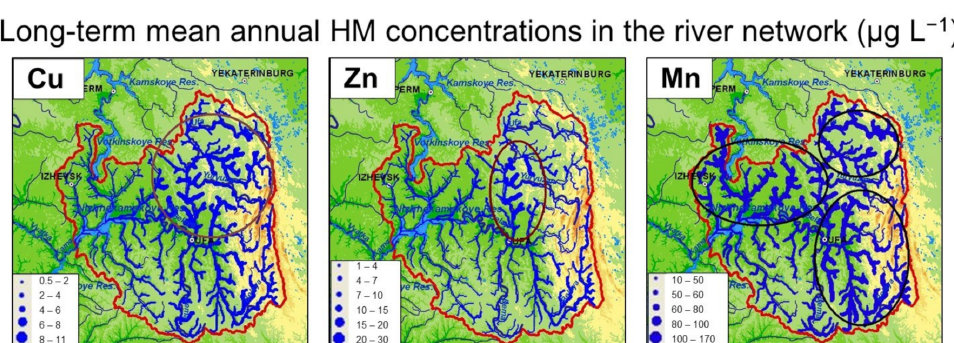
Figure 7. Initial HM contents in the soils, long-term mean annual HM wash-off, and long-term mean annual HM concentrations in the river